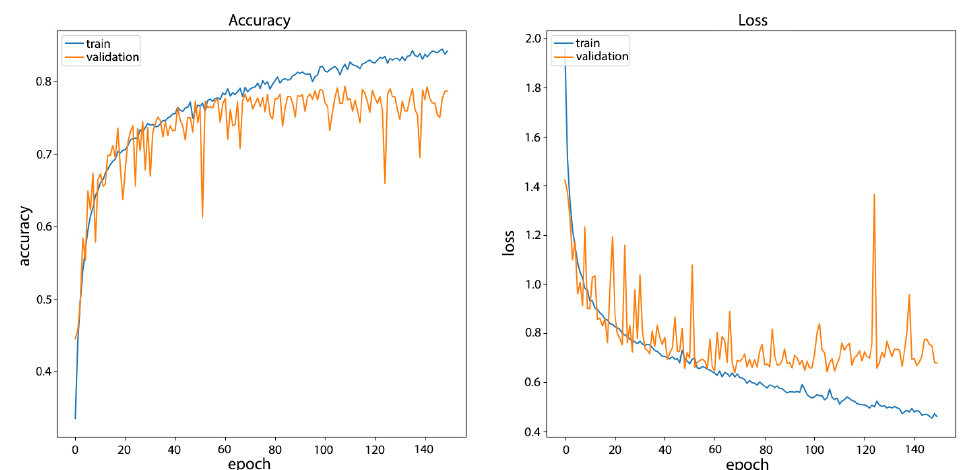
Figure 9. CNN Model_F3 training results on UTKFace filtered dataset with plotted landmarks.